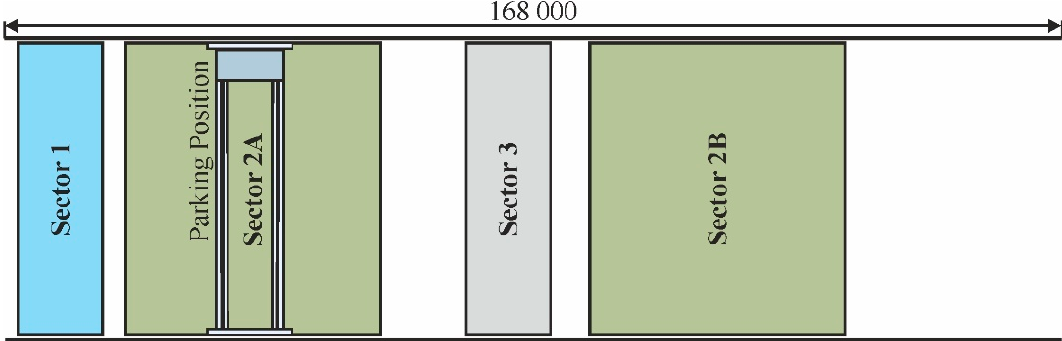
Figure 2. View of the travelling track of the bridge crane and the steel coil handling locations.